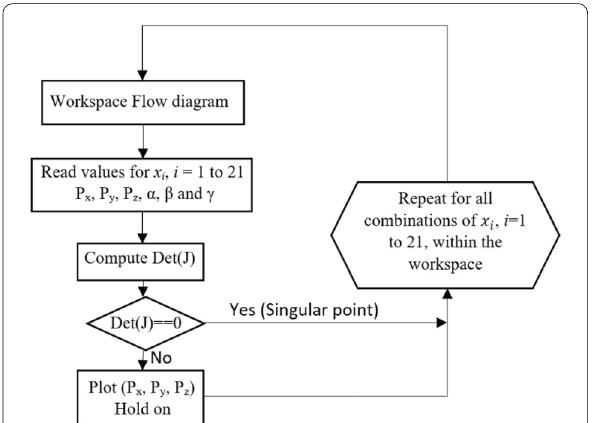
Figure 10 Singularity analysis flow